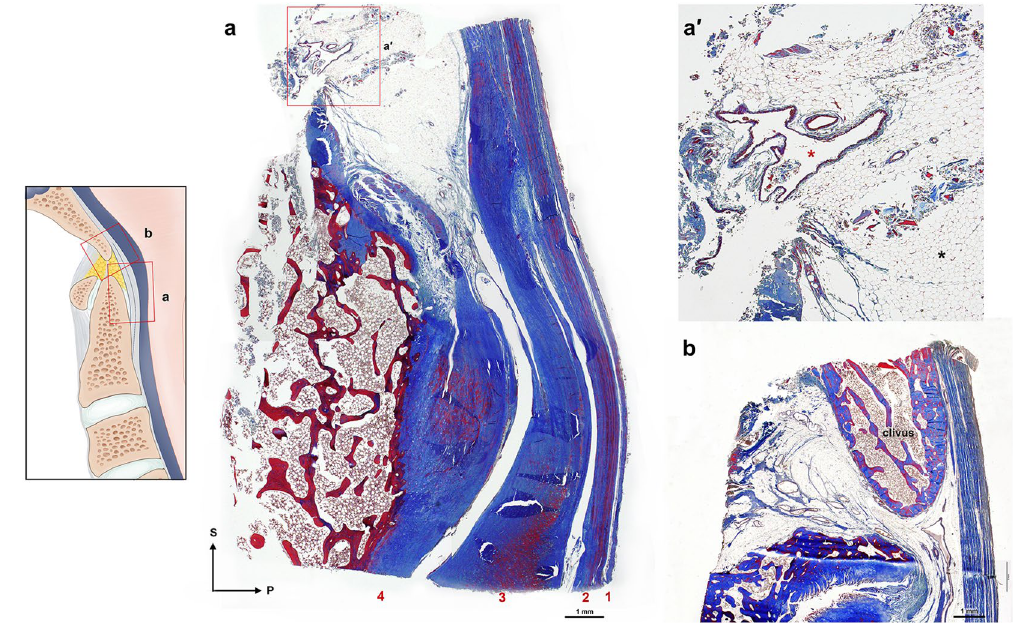
Figure 4. The tectorial membrane (TM) in the sub-clival level. Masson’s trichrome stain. ( a ) Sagittal view of the sub-clival area of the cruciate ligament–TM–dura mater complex. 1, spinal dura mater; 2, TM; 3, cruciate ligament; 4, hypertrophied cartilage of the dens. ( a ′ ) Magnification of a box in ( a ). The venous plexus (red asterisk) in the adipose tissues (black asterisk) of the supradental space. ( b ) The cruciate ligament–TM–dura mater complex departs from the inferior clivus and forms the posterior boundary of the supradental space filled with adipose tissues and venous plexus intermingled with sparse fibrous tissues